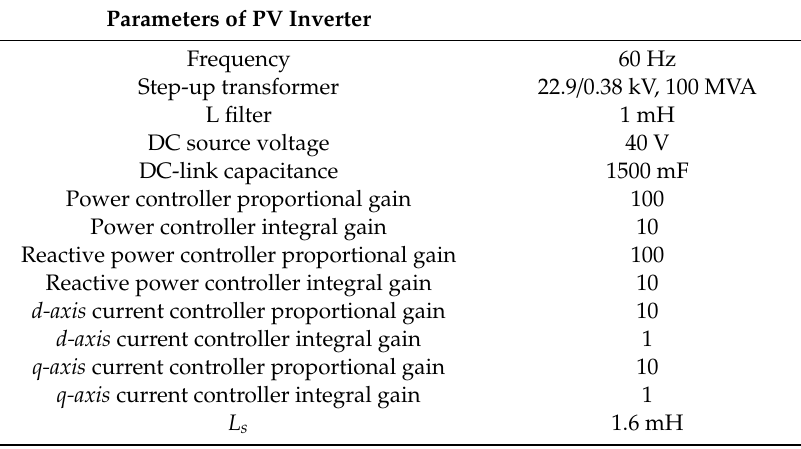
Table A1. Converter parameters and controller gains for PV inverter.